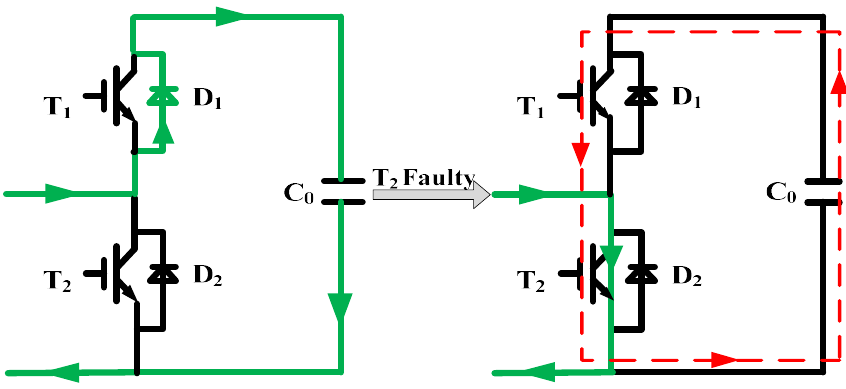
Figure 4. Current path when T 2 is short-circuit with i arm > 0 and S = 1.